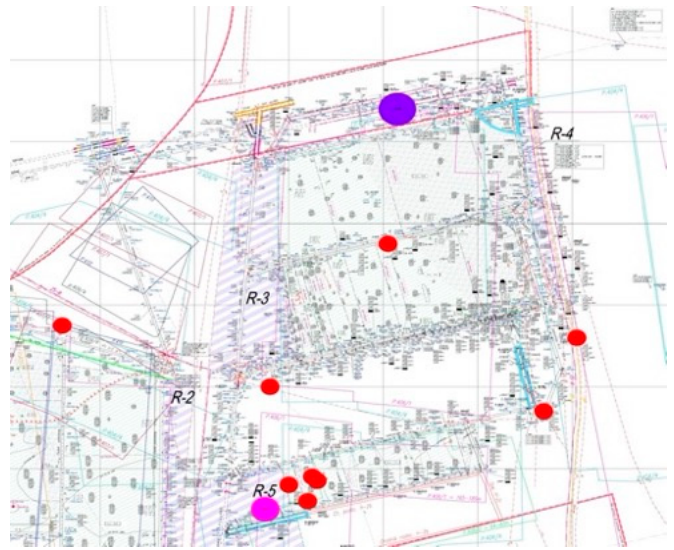
Figure 6. The map of seam 409/3 in the area of longwall H-4 with indicated spots where bumps occurred with an energy of 10 6 –10 8 J.